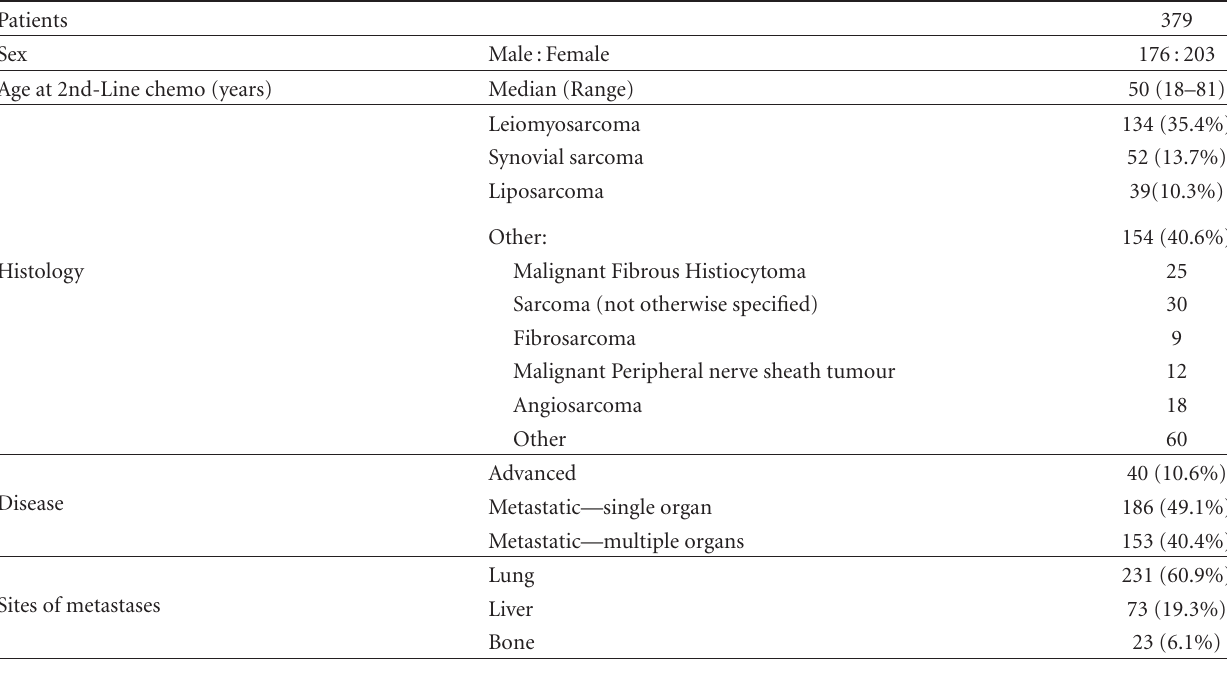
Table 1: Clinical characteristics.